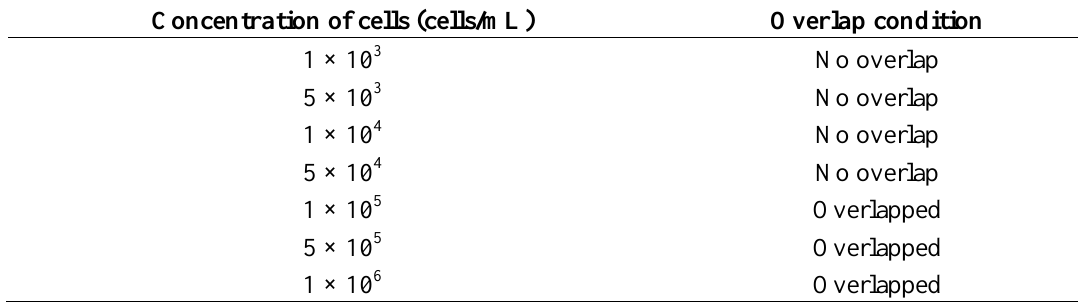
Figure 3. Measured chlorophyll fluorescence of the living and dead microalgae cells of five microalgae species: ( a ) Platymonas subcordiformis ; ( b ) Dunaliella salina ;